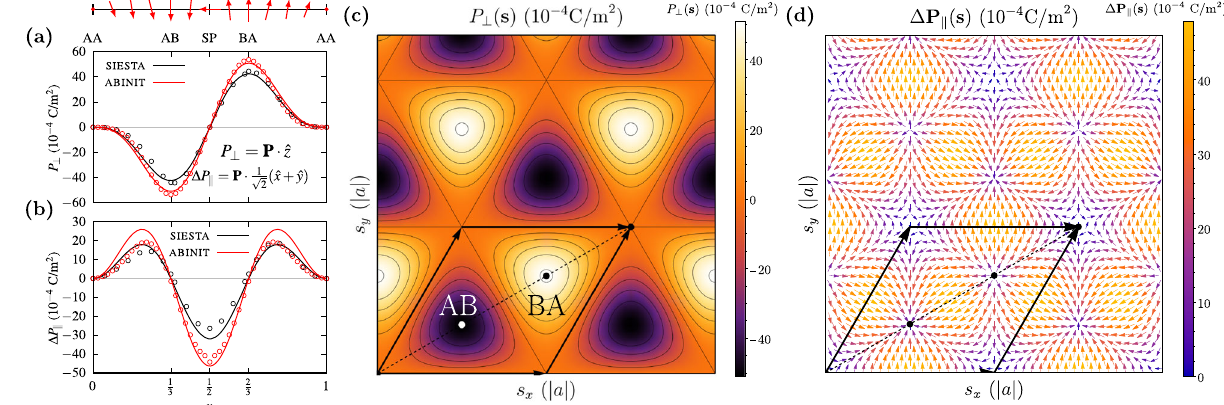
Fig. 2 | Total polarization in bilayer hBN. a Out-of-plane polarization P ⊥ and b change in in-plane polarization Δ P ∥ in fractional coordinates along the con fi g- uration space diagonal, calculated with SIESTA (black) and ABINIT (red), where ^ x and ^ y are the normalized lattice vectors of the bilayer, and ^ z is the unit vector normal to the bilayer.The hollow points are fi rst-principles measurements and the solidlines